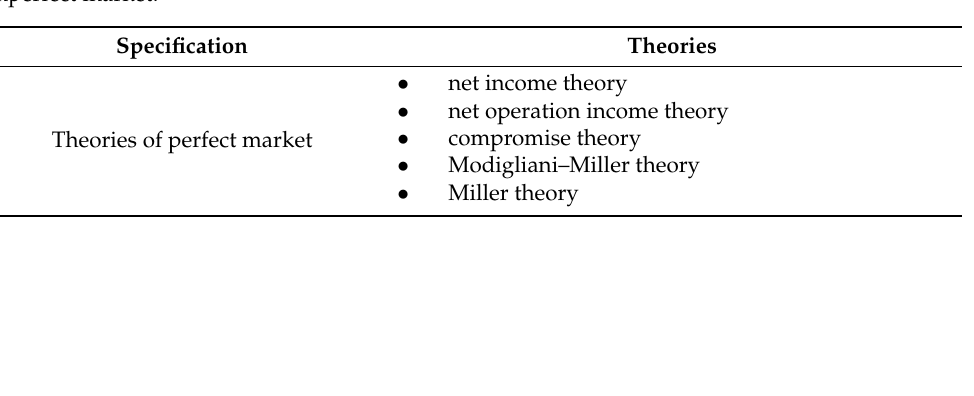
Table 2. Classification of capital structure theory from the perspective of perfectly competitive and imperfect